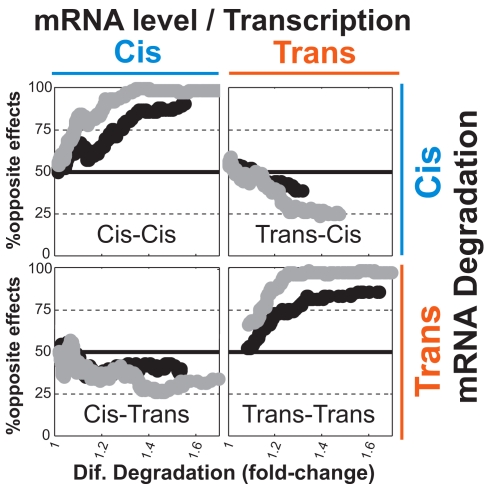
Enrichment of opposite effects only for cis-cis and trans-trans combinations supports a mechanistic coupling.Inter-species differences in mRNA levels (or estimated transcription rates) and mRNA degradation were divided into the contribution of cis- and trans-mutations based on the hybrid data. The enrichment of opposite transcription and degradation effects was examined for each of the four combinations of cis and trans, by a sliding window analysis of the percentage of opposite effects as a function of the fold-changes in mRNA degradation.